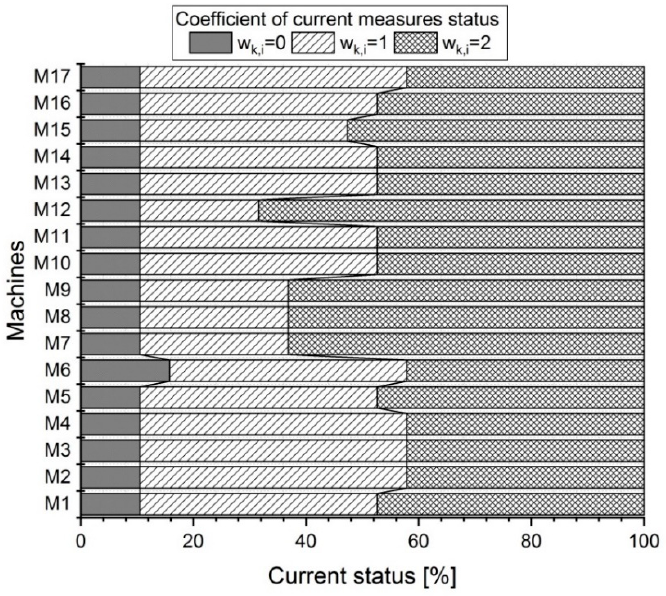
Figure 4. Evaluation of current measures status on machines of operation I (source: own design).